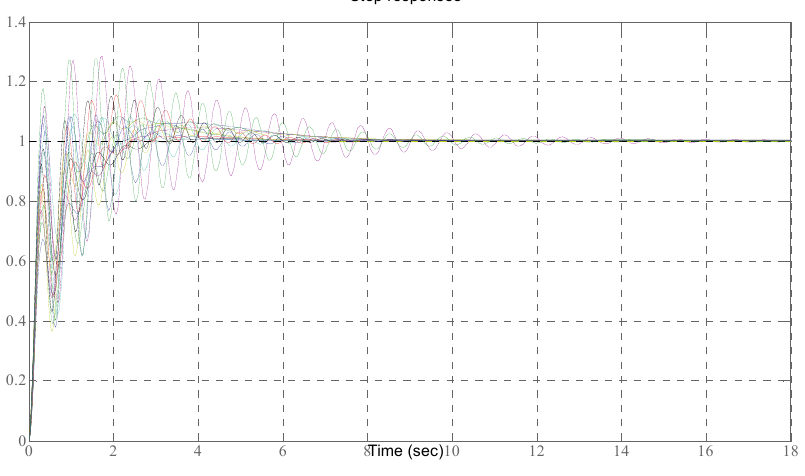
Fig.5. Step responses with all 16 Kharitonov plants by Hsu and Yu 18